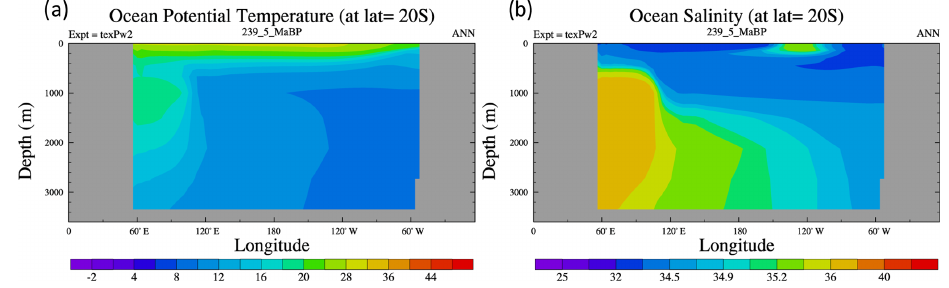
Figure 8. Longitudinal cross section at 20 ◦ S of (a) ocean potential temperature and (b) salinity for the Ladinian (240Ma). Temperature is in Celsius and salinity is in